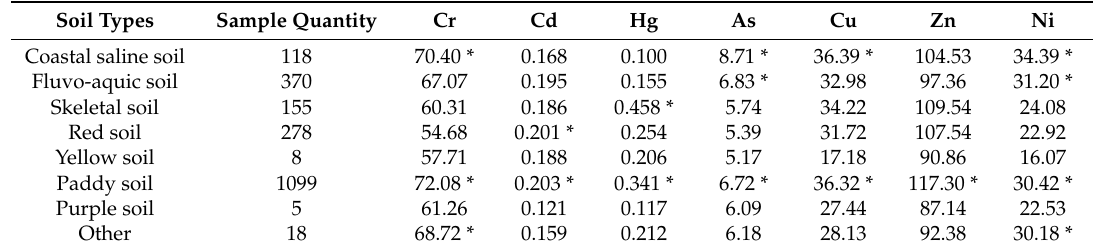
Table 4. Average concentrations of trace elements in the different soil types (mg/kg).